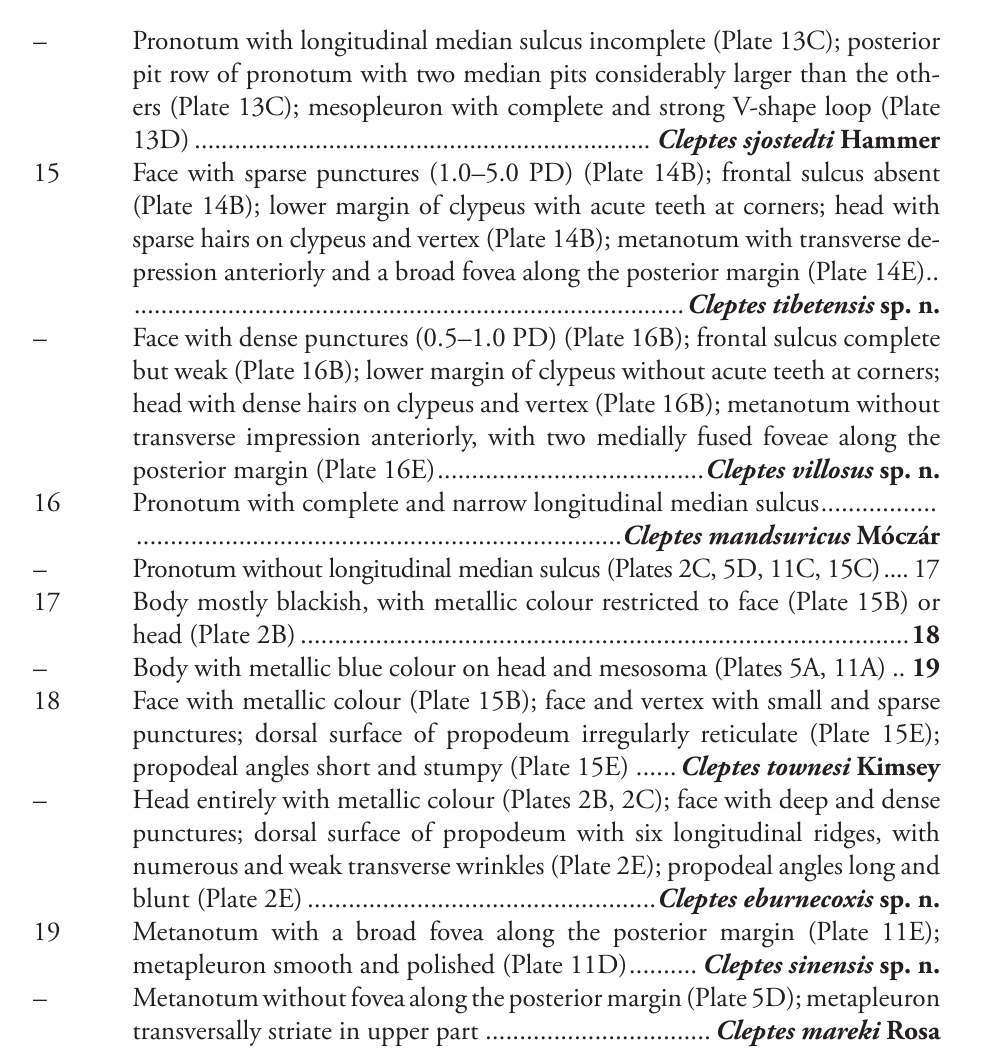
– Pronotum with longitudinal median sulcus incomplete (Plate 13C); posterior pit row of pronotum with two median pits considerably larger than the oth- ers (Plate 13C); mesopleuron with complete and strong V-shape loop (Plate 15 Face with sparse punctures (1.0–5.0 PD) (Plate 14B); frontal sulcus absent (Plate 14B); lower margin of clypeus with acute teeth at corners; head with sparse hairs on clypeus and vertex (Plate 14B); metanotum with transverse de- pression anteriorly and a broad fovea along the posterior margin (Plate 14E) .. – Face with dense punctures (0.5–1.0 PD) (Plate 16B); frontal sulcus complete but weak (Plate 16B); lower margin of clypeus without acute teeth at corners; head with dense hairs on clypeus and vertex (Plate 16B); metanotum without transverse impression anteriorly, with two medially fused foveae along the 16 – Pronotum without longitudinal median sulcus (Plates 2C, 5D, 11C, 15C) ....17 17 Body mostly blackish, with metallic colour restricted to face (Plate 15B) or head (Plate 2B) ......................................................................................... 18 – Body with metallic blue colour on head and mesosoma (Plates 5A, 11A) .. 19 18 Face with metallic colour (Plate 15B); face and vertex with small and sparse punctures; dorsal surface of propodeum irregularly reticulate (Plate 15E); propodeal angles short and stumpy (Plate 15E) ...... Cleptes townesi Kimsey – Head entirely with metallic colour (Plates 2B, 2C); face with deep and dense punctures; dorsal surface of propodeum with six longitudinal ridges, with numerous and weak transverse wrinkles (Plate 2E); propodeal angles long and 19 Metanotum with a broad fovea along the posterior margin (Plate 11E); metapleuron smooth and polished (Plate 11D) .......... Cleptes sinensis sp. n. – Metanotum without fovea along the posterior margin (Plate 5D); metapleuron transversally striate in upper part ................................. Cleptes mareki Rosa